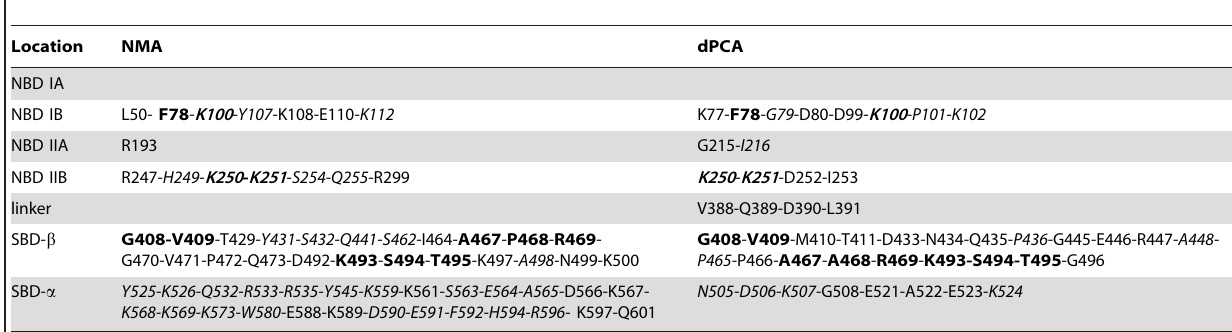
Table 4. List of residues found to be relevant for conformational dynamics of human Hsp70 deduced from NMA of human Hsp70 [49,92] and from dPCA of E. coli MD trajectories (present work) after sequence alignment of E. coli DnaK on human Hsp70 (Table